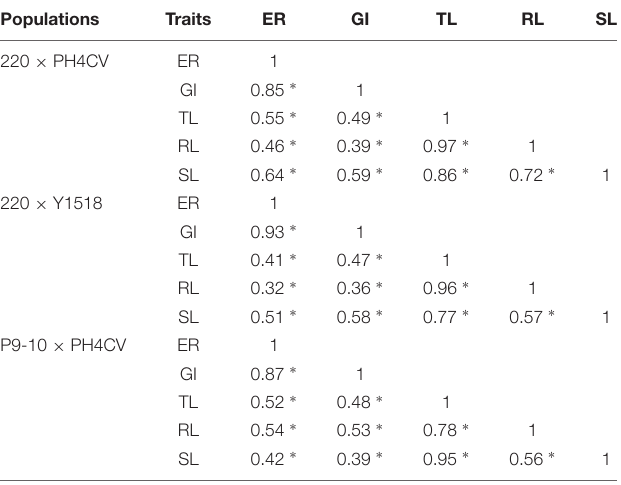
TABLE 2 | Phenotypic correlation between emergence rate (ER), germination index (GI), total length (TL), root length (RL), and shoot length (SL) in